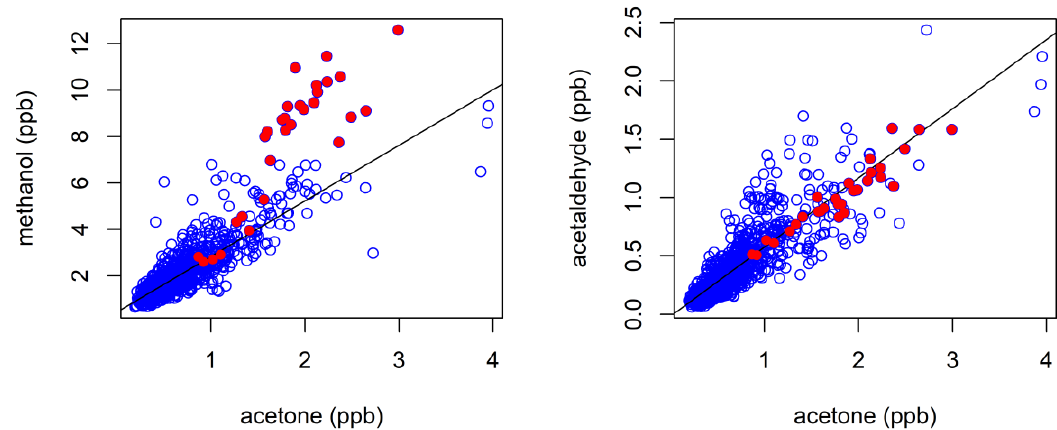
Figure A5. As in Figure 8, but with the hot days data included in red.